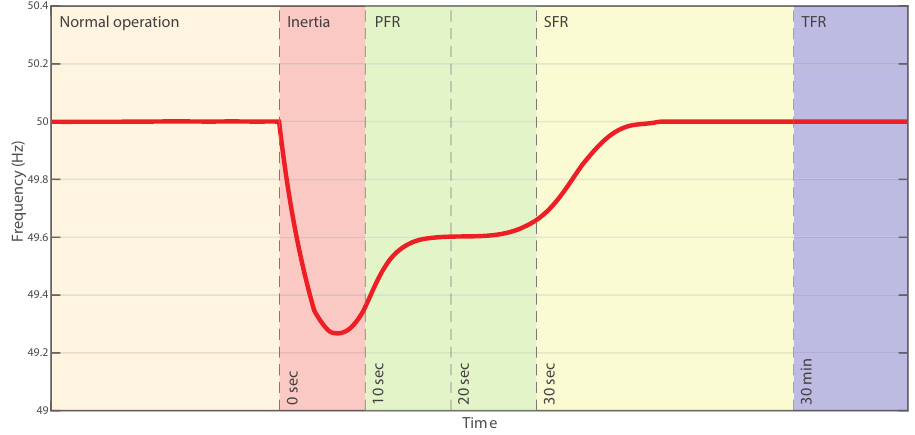
Figure 2. The subsequent effects of primary, secondary, and tertiary frequency regulation after an unexpected loss of